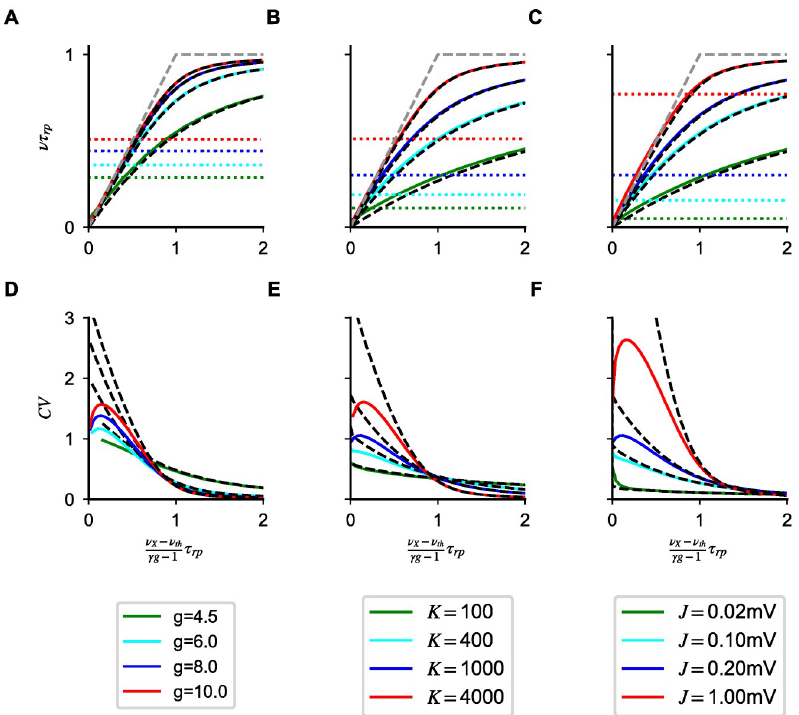
Fig 3. Saturation nonlinearities in Model A. Transfer function (first row) and CV (second row) computed numerically from Eqs (3)–(5) and (6) (continuous lines) for different g (first column), C (second column) and J (third column). As in Fig 2, colored dotted lines in the first row represent values of the rates at which u max = − 1. Black dashed lines solutions of the approximated Eqs (13) and (14). This validation of the approximated rate equation motivates the perturbative approach used in the main text and allows to classify nonlinearities in a general way. Simulation parameters: J = 0.2 mV, K = 10 3 in ( A , D ); g = 5.0, J = 0.1mV in ( B , E ); g = 5.0, K = 10 3 in ( C , F ); in all plots g = 1, τ =